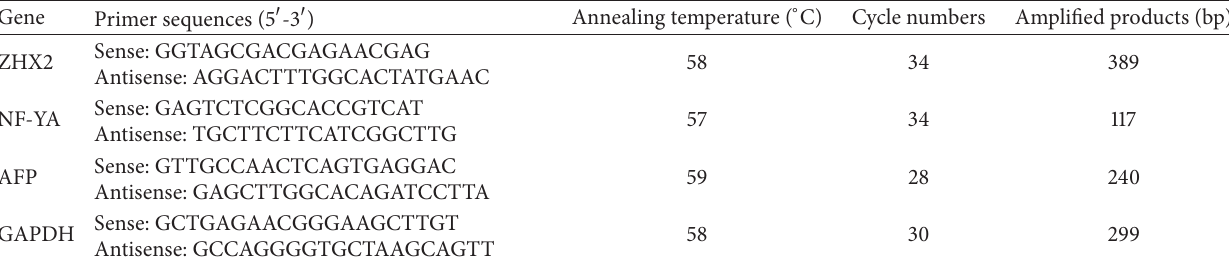
Table 1: Primer sequences for RT-PCR analysis.